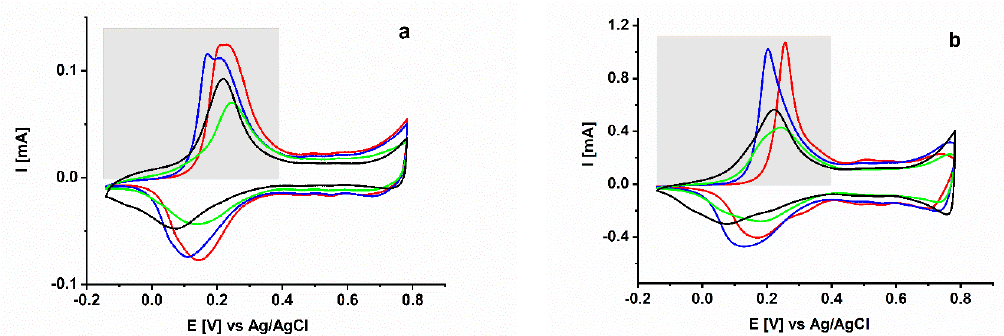
Figure 3. Voltammetric scan measured in 0.5 M H2SO4 at thin ( a ) and thick ( b ) PANI layers obtained in the presence of PAMPSA (black), t-PASA (blue), i-PASA (red) and PSSA (green). Grey rectangles denote the area where integration of the oxidative peaks was carried out to obtain the values of Q ox .